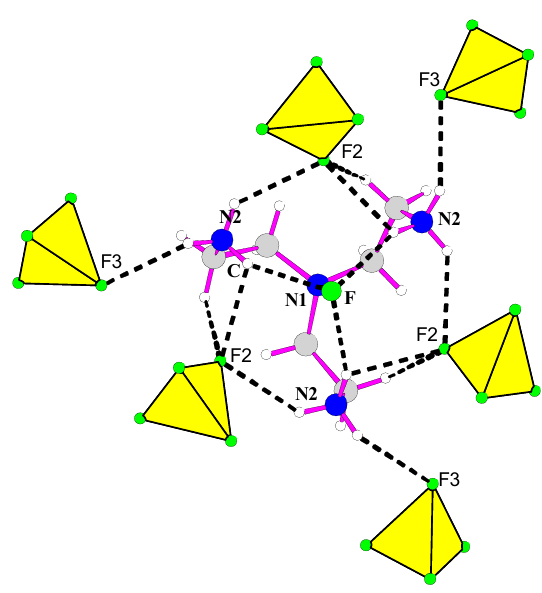
Figure 5. Hydrogen bonds in [H 3 tren ](BF 4 ) 3 HF.